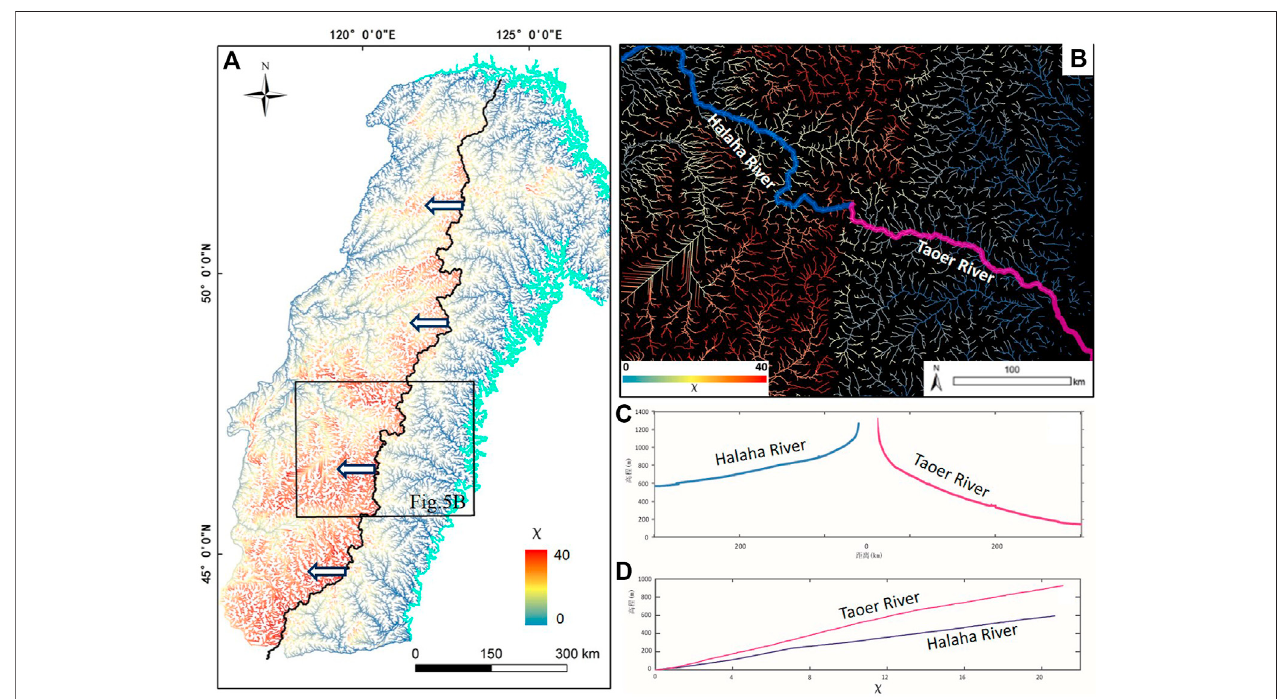
FIGURE5| χ map oftheGreaterKhinganMountains (A) .Thetypical areawithenormousdifferencesin χ values (B) .Elevationpro fi leofthemainriversinthetypical area (C) . Chi plot of the main rivers in the typical area (D) .